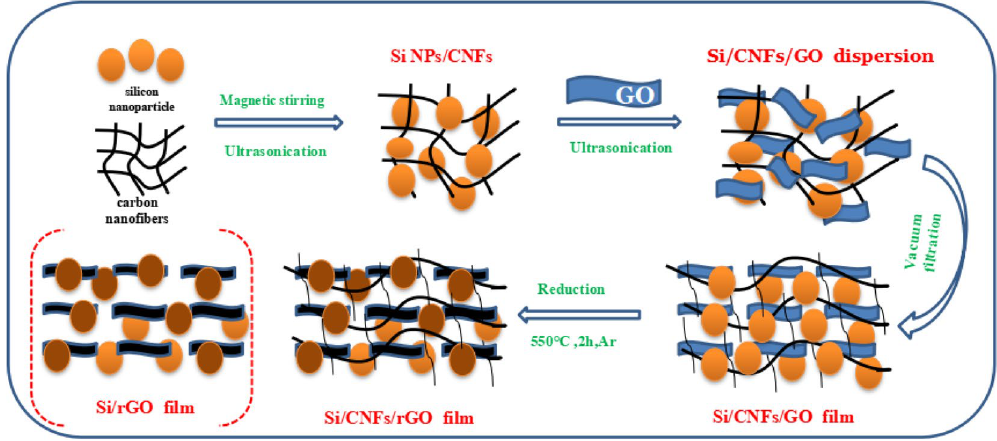
Figure 1. Preparation process of Si/CNF/rGO and Si/rGO composite